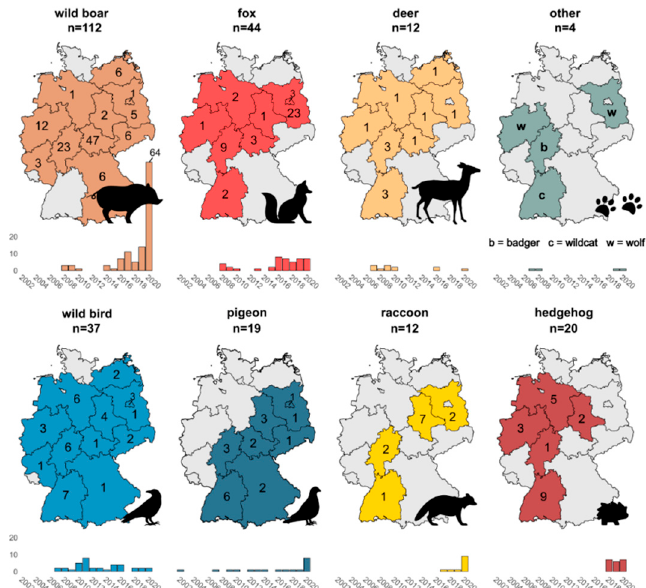
Figure 1. Geographic and temporal distribution of the investigated wildlife Salmonella enterica isolates.The figure gives a visual overview of the geographical origin of the investigated wildlife Salmonella enterica isolates, grouped by host species, with the total number of samples per host species displayed above each graph. The German federal states that were sampled are highlighted in colour with the total number of samples obtained from each federal state indicated. A timeline below each graph indicates the sampling years when isolates were